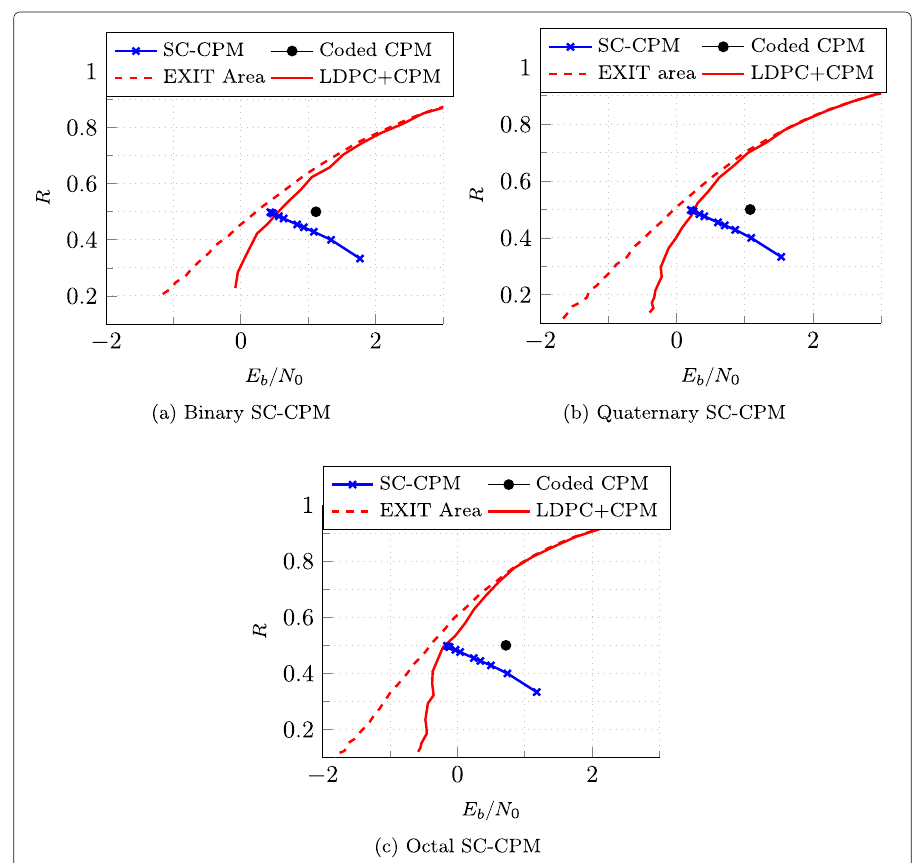
Fig. 8 Threshold of coupled and uncoupled coded CPM. Comparison to the area under the EXIT is also depicted. The coupling matrix here is B = [ 1